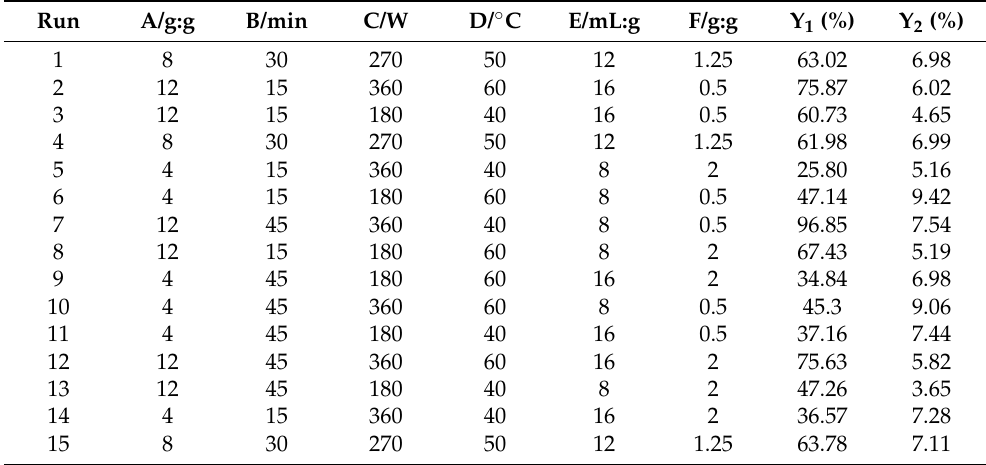
Table 5. Design and results of PBD with Y 1 and Y 2 as responses.